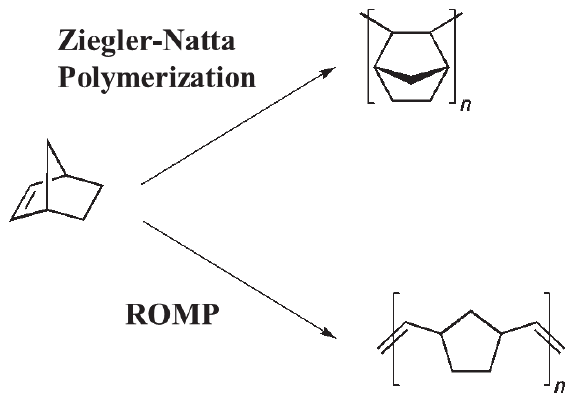
Figure 50. Ziegler-Natta polymerization and ring-opening metathesis polymerization (ROMP) of